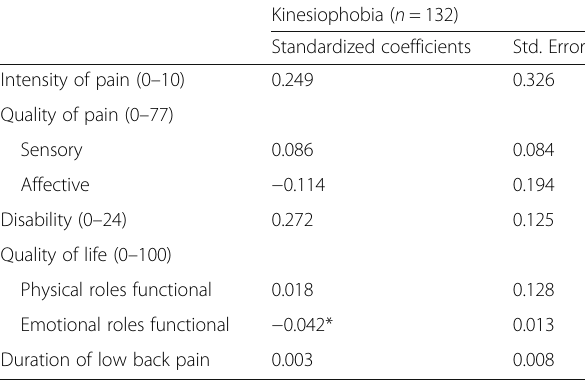
Table 3 Multiple linear regression model of the comparison between kinesiophobia scores and the clinical